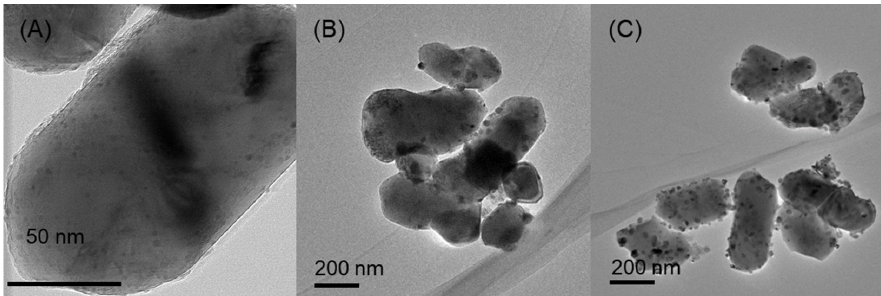
Figure 3. TEM images of 650 °C reduced ( A ) 1Ni/r-TiO 2 , ( B ) 5Ni/r-TiO 2 , and ( C ) 10Ni/r-TiO 2 catalysts. Table 2. Ni particle size and dispersion of 1Ni/r-TiO 2 , 5Ni/r-TiO 2 , and 10Ni/r-TiO 2